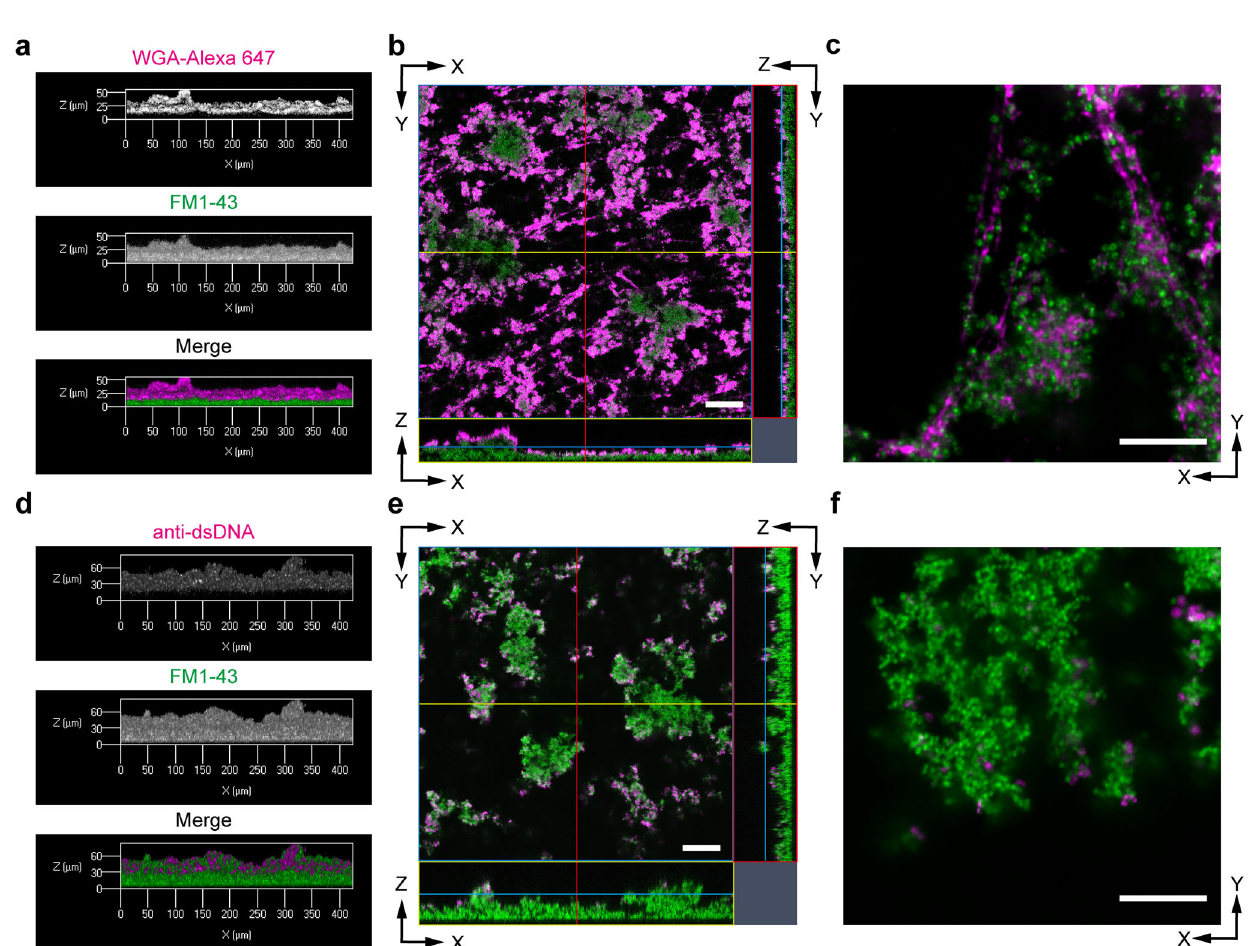
Fig. 4 Application of the iCBio fi lm method to visualize polysaccharide intercellular adhesin (PIA) and eDNA in S. aureus bio fi lms. a – c Confocal laser scanning microscopy (CLSM) images of the S. aureus MR10 bio fi lm stained with WGA-Alexa 647 (PIA, magenta) and FM1-43 (cells, green). d – f CLSM images of the S. aureus MR23 Δ spa Δ sbi bio fi lm stained with anti-dsDNA mouse monoclonal antibody and Alexa 647-conjugated anti-mouse IgG (eDNA, magenta) and FM1-43 (cells, green). The bio fi lm was soaked in 35.2% (w/w) iohexol solution. The typical side views of the bio fi lms ( a , d ), orthogonal images ( b , e ), and the X-Y sections for the selected z-stack positions ( c , f ) acquired using ×20 and ×63 objective lenses are shown. Scale bars are 50 μ m in b , e and 10 μ m in c , f (Fig. 6c). Indirect immuno fl uorescence microscopy using an anti- Curli antibody showed the distribution of Curli proteins throughout the aqueous bio fi lm (Fig. 6d, e). A close-up view revealed the existence of fi brillar structures stained with the anti- Curli antibody, and cells were encased in a network of Curli fi bers (Fig. 6f).